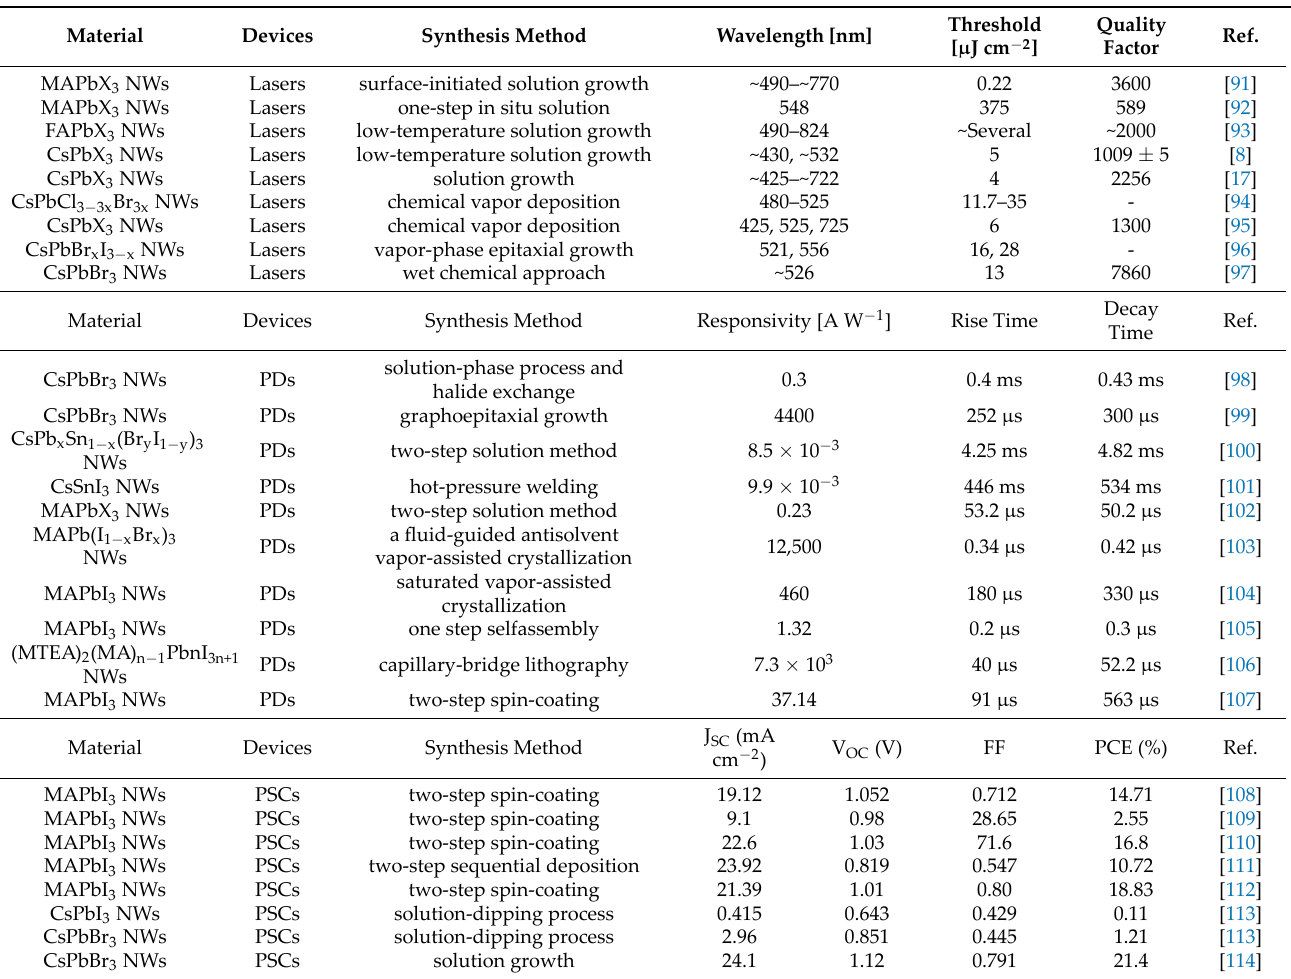
Table 2. The parameters of different devices based on halide perovskite